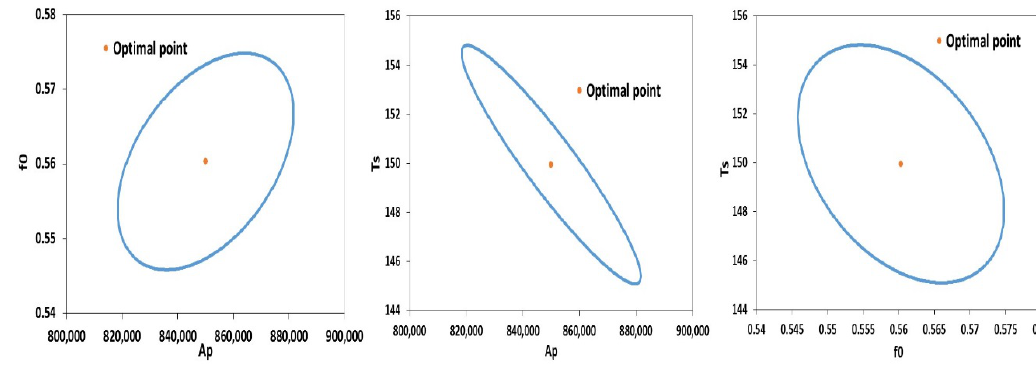
Figure 7. Confidence ellipsoids for final estimated parameters.